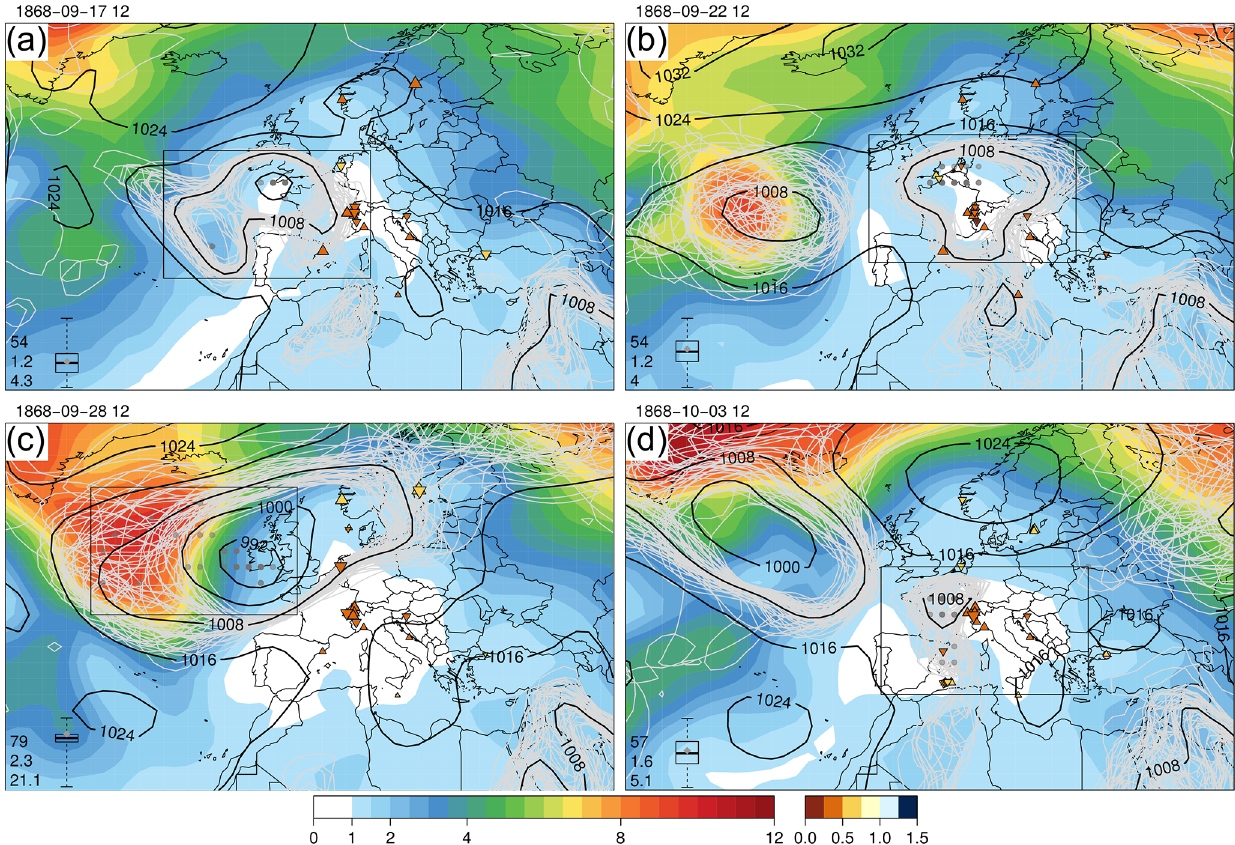
Figure A2. Mean sea level pressure (hPa) calculated from 20CR for (a) 17 September 1868 12:00UTC, (b) 22 September 1868 12:00UTC, (c) 27 September 1868 12:00UTC and (d) 3 October 1868 12:00UTC. The background color shade indicates the standard deviation (“spread”) of the ensemble (hPa). Light grey contours indicate the 1008hPa isobars for all 56 ensemble members. Bold black contours show the isobars in the 20CR ensemble mean. Grey dots mark the locations of pressure minima for all ensemble members within the inset box; the darker the dot, the more members have the minimum pressure at this grid point. The box plot in the lower left corner of each panel indicates the median, interquartile range and full range of the ensemble pressure minima; the grey diamond indicates the pressure minimum in the ensemble mean. From top to bottom, the values to the left of the box plot indicate the position of the ensemble mean with respect to the according percentile (%) of the ensemble members, the interquartile range and the full range of the ensemble members in hPa. Triangles mark the locations of the pressure observations that are available for assimilation into 20CR from 06:00 to 12:00UTC at the specific date (ISPD; Cram et al., 2015). The adjustment effect (magnitude qualitatively shown by the size of the triangle) by the pressure measurements towards weakening and deepening of the surrounding pressure fields is shown with upward-pointing and downward-pointing triangles, respectively; the color shade represents the ratios of the ensemble spread in the analysis with respect to the first guess forecast (see also Compo et al.,